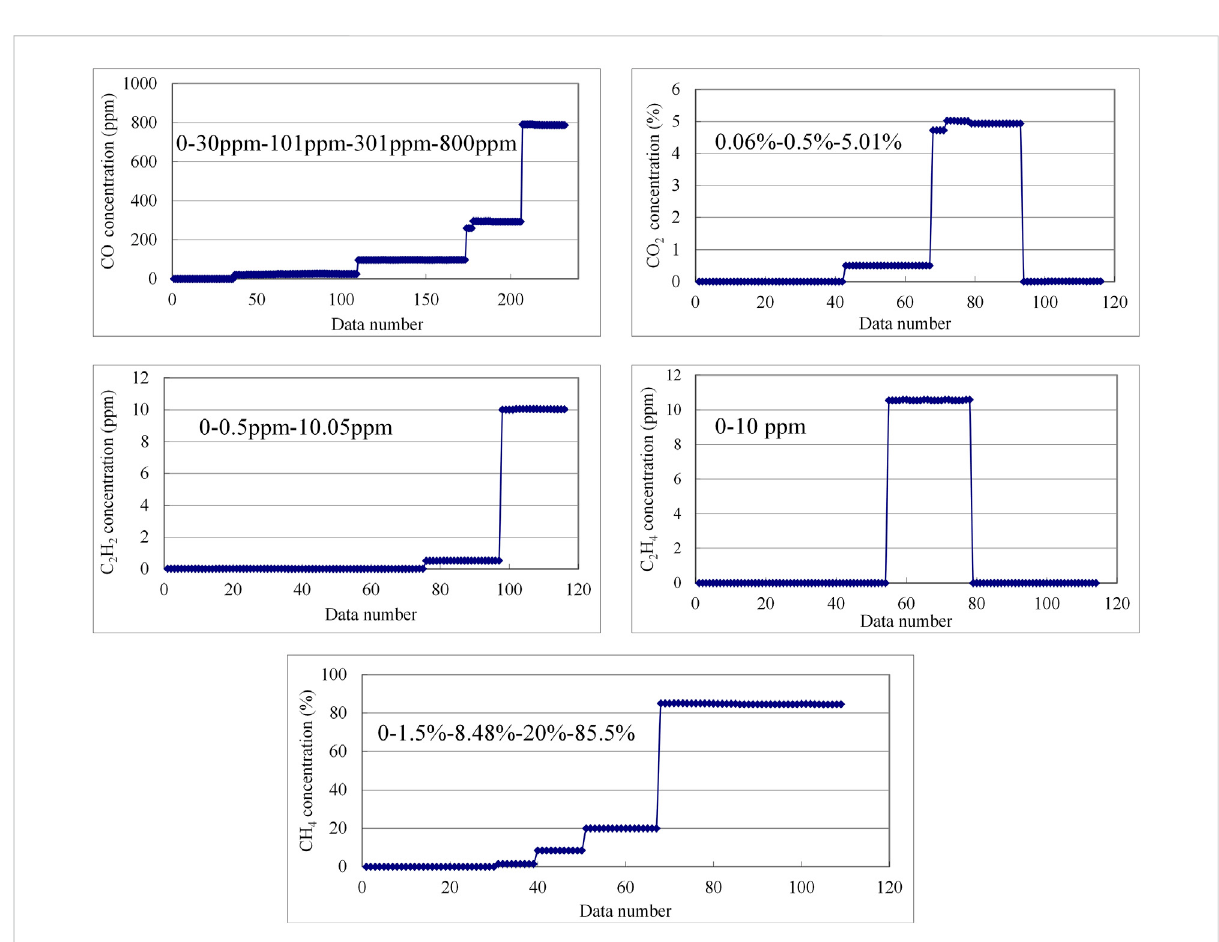
FIGURE 9 The test data of laser multi-gas monitoring